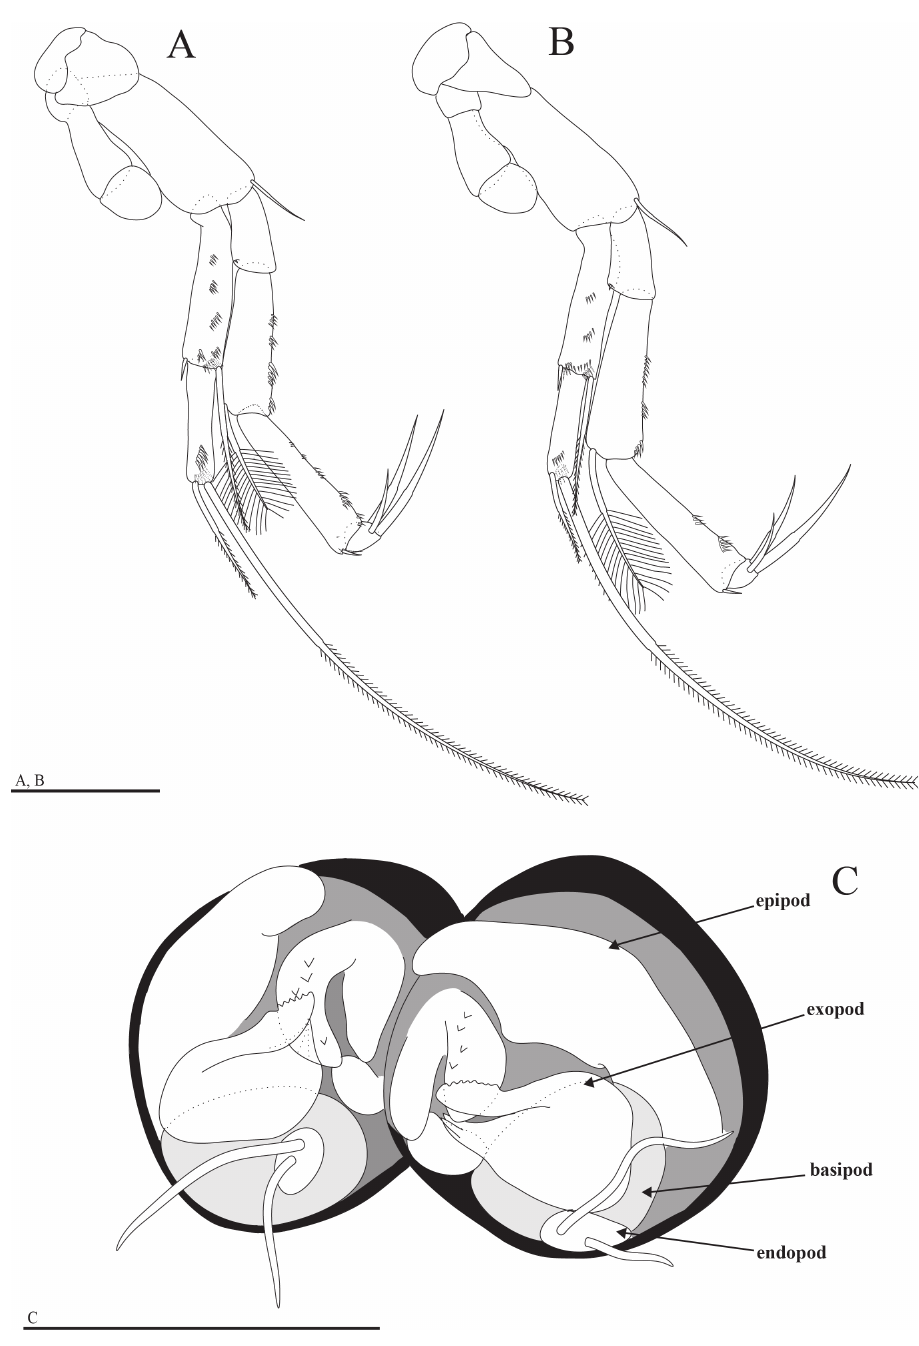
Figure 4. Hangangbathynella mihoensis sp. nov., holotype male A thoracopod VI (frontal) B thoracopod VII (frontal) C thoracopod VIII (ventral). Scale bars: 0.05